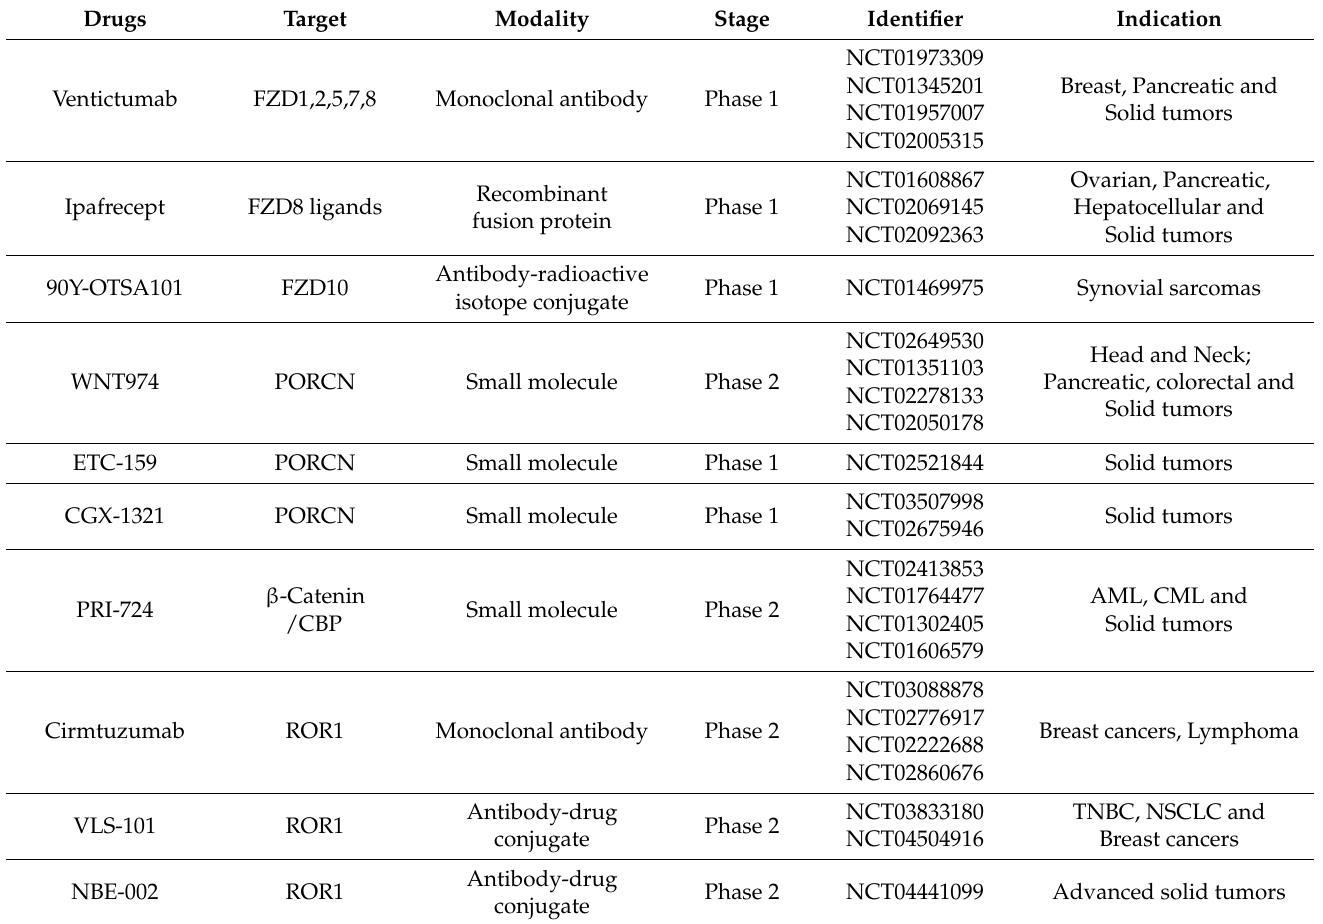
Table 1. Key WNT pathway inhibitors in clinical